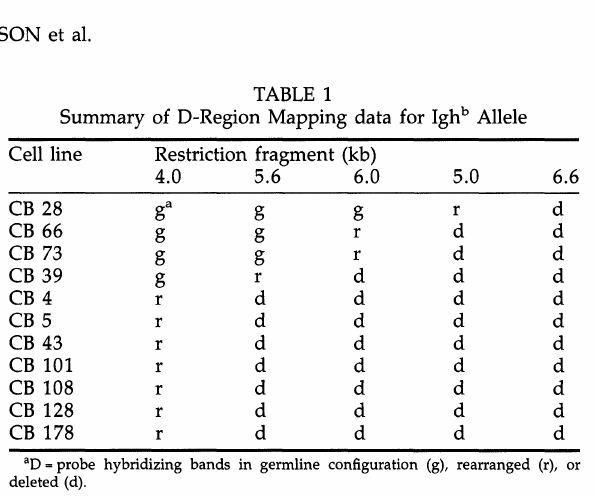
Summary of D-Region Mapping data for Igh b Allele ell line